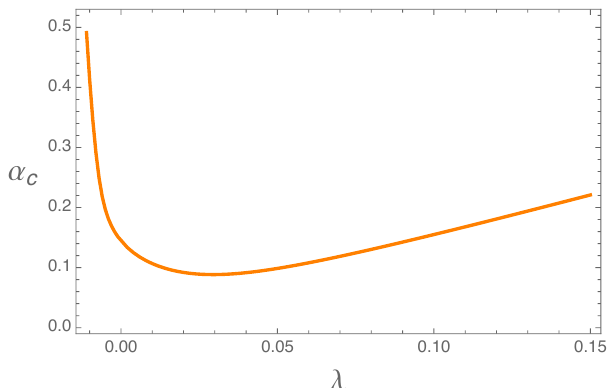
Figure 2 . The critical Chern-Simons coupling (cid:11) c as a function of (cid:21) for the local minimum in the mass square being equal to the BF bound. Note that (cid:11) c (cid:11) c < (cid:11) , the minimal mass square is below the BF bound at value k < k s .